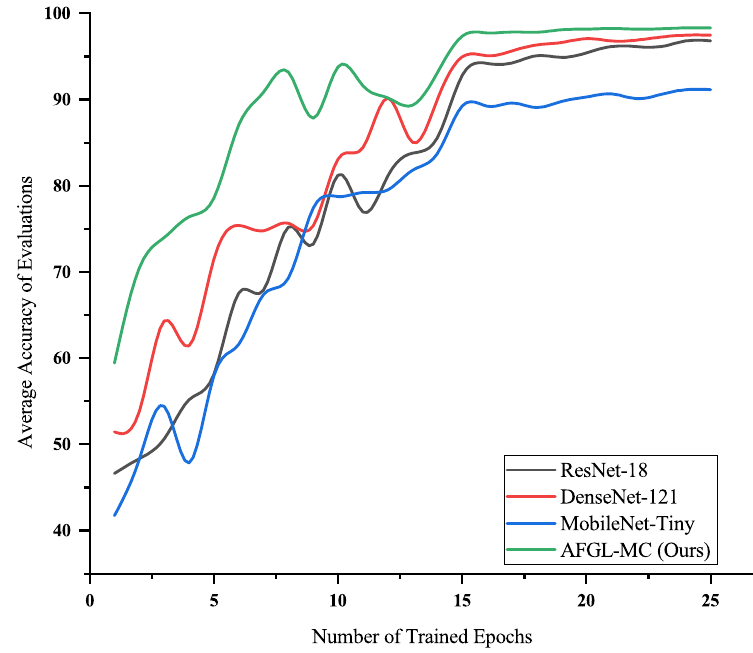
Figure 11. The evaluation results on FQ